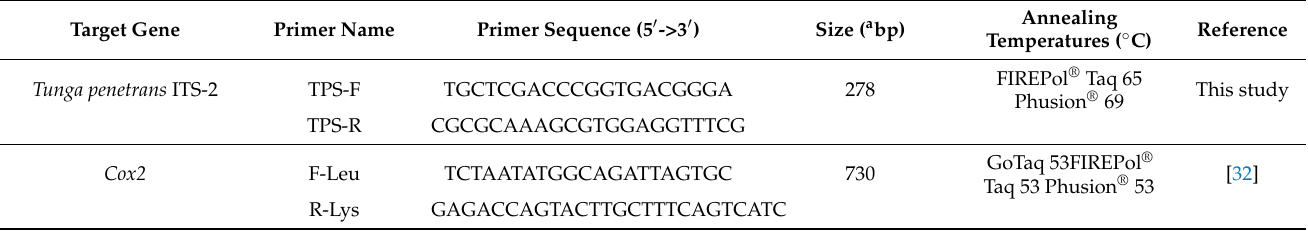
Table 1. Primer information. Target gene and primer sequences for both forward and reverse